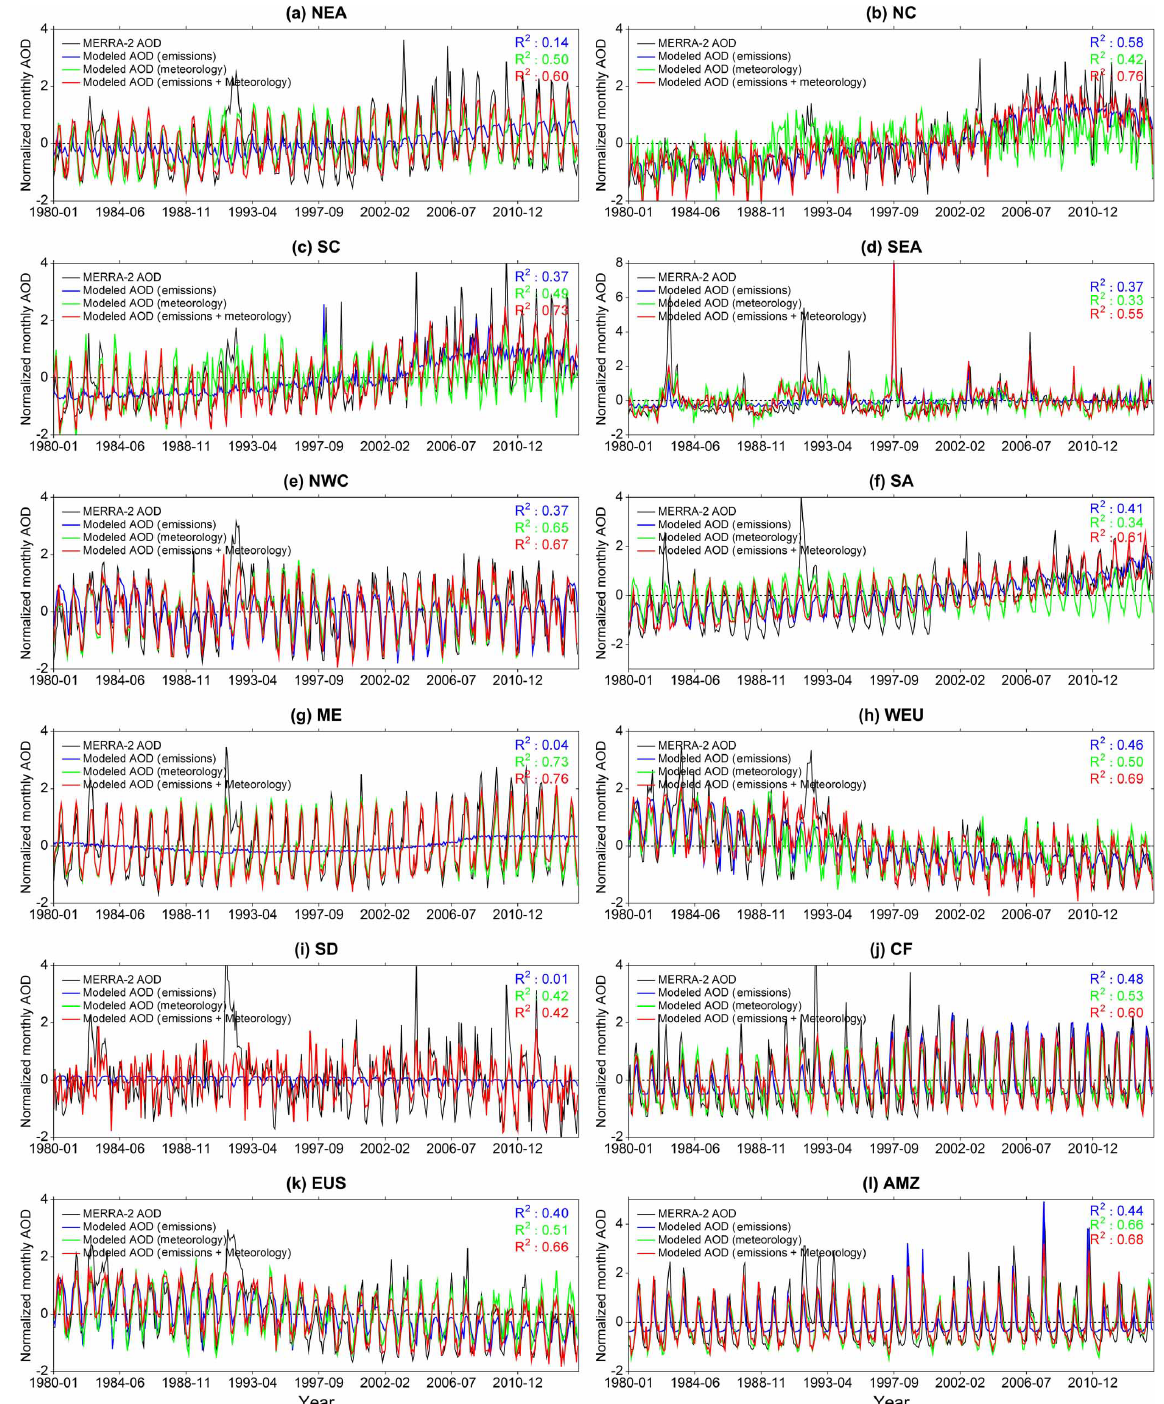
Figure 12. Time series of MERRA-2 (in black) and modeled AOD monthly normalized anomalies from 1980 to 2014 over the 12 regions of interest. The coefficient of determination ( R 2 ) of the regression fit of the stepwise MLR model with emission factors (in blue), meteorology (in green), and both emissions and meteorology (in red) as predictors are given in the top-right of each panel.